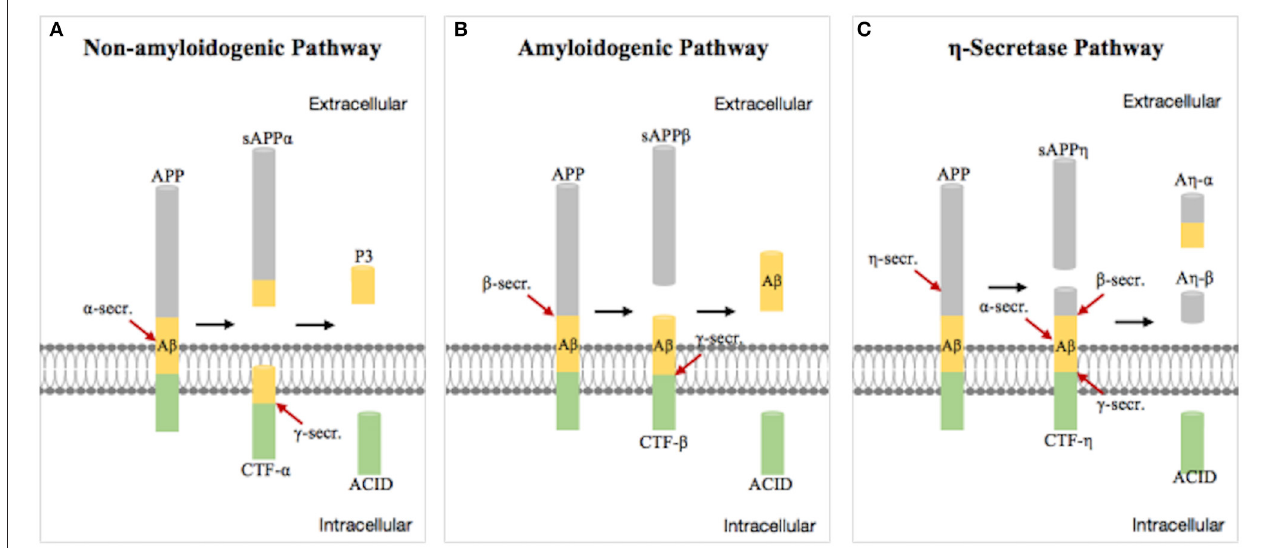
FIGURE 1 | Schematic diagram of the progressive cleavages of the amyloid beta (A β ) precursor protein (APP) transmembrane domain. A β peptide is generated from APP processing via the amyloidogenic pathway (B) . (A,C) are non-amyloidogenic pathological pathway under physiological conditions.